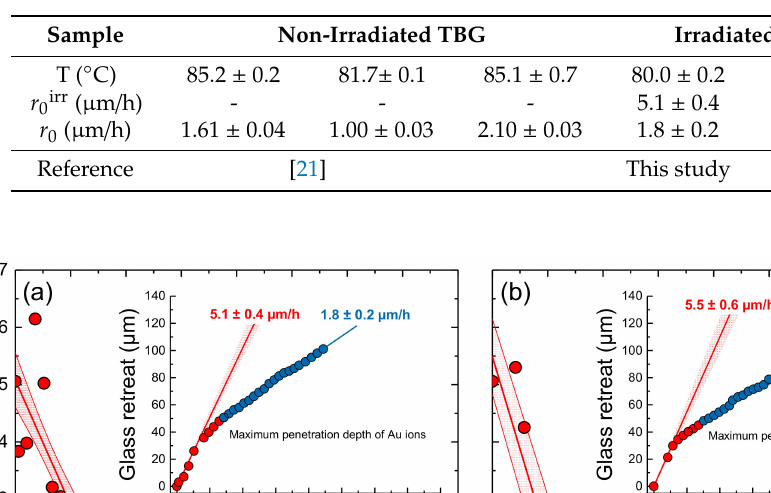
Table 1. Summary of forward dissolution rates of non-irradiated, r 0 , and irradiated TBG, r 0irr , obtained by in situ fluid-cell Raman spectroscopy. The uncertainties were obtained from the least-squares fit (Figure 5) and are given at the 1-sigma level.